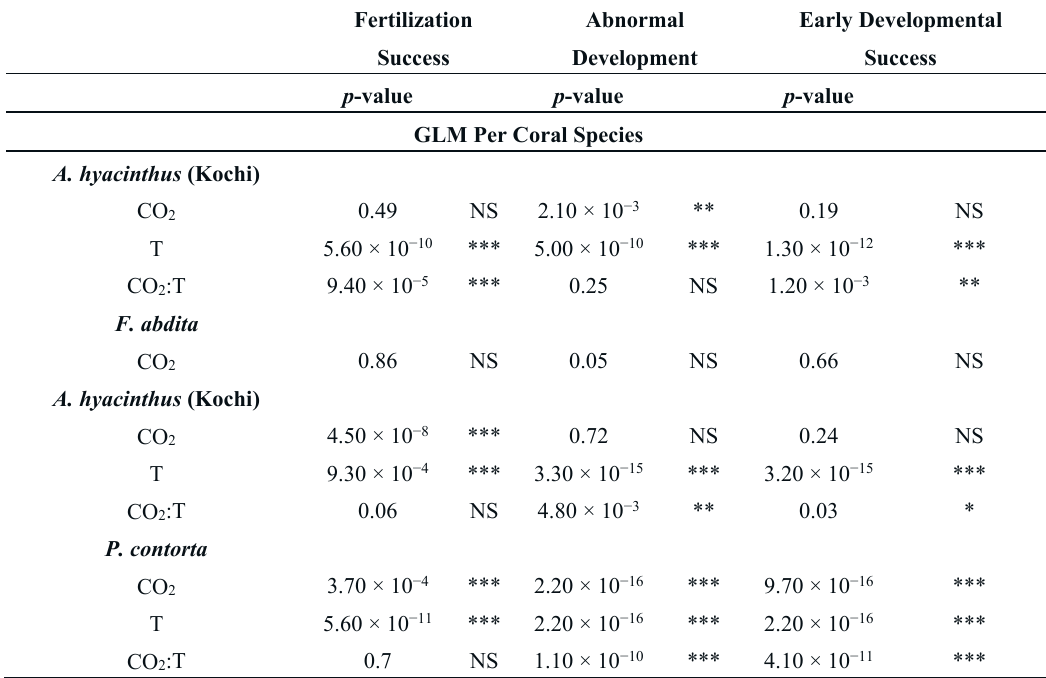
Table 2. Table showing the results (p-values) of the multiple comparison test of interactive effects for fertilization rate, abnormal development and early developmental success of the different coral species. Additionally, in the case of a significant difference, it is indicated whether there is a positive (+) or negative (-) effect. NS = not significant. ( n = 5 per species). Effect of Temperature